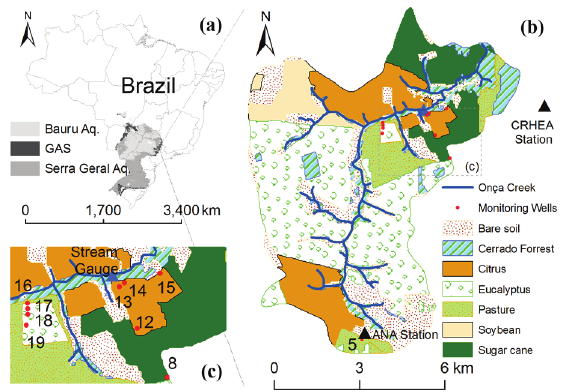
Figure 1 - Location of the Onça Creek basin (OCB) in the Guarani Aquifer System (GAS) outcrop zone in Brazil (a) ; 2014 land use distribution within OCB (b) and detailed map showing the monitoring wells and stream gauge location (c) .